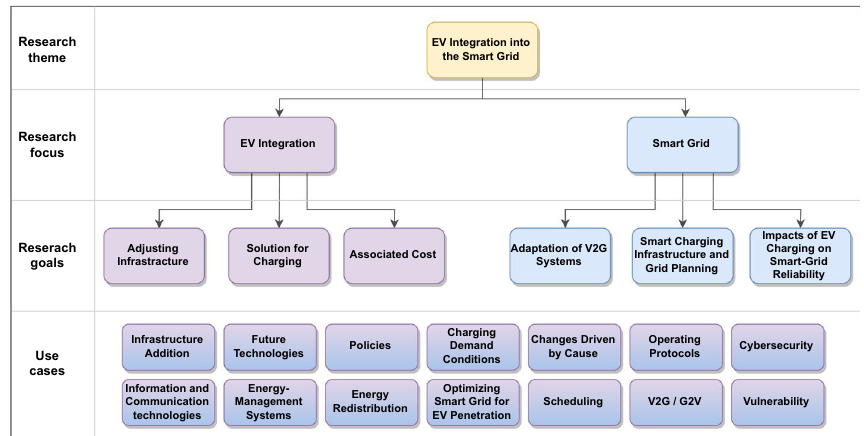
Fig. 2 Smart-grid–EV-integration research